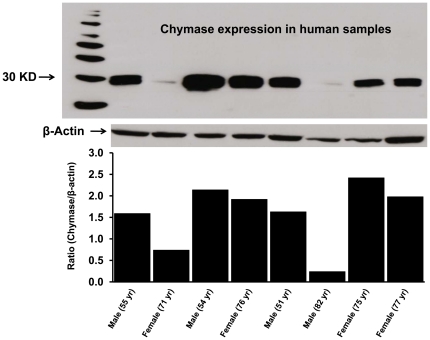
Chymase protein expression in human atrial tissue.Chymase protein expression in human atrial samples was analyzed by western blotting using a primary monoclonal anti-human chymase antibody (CMA1 antibody from R&D System, Cat# MAB-4099; 2 µg/mL). The plasma membrane (50 µg protein) were separated by gel electrophoresis and transferred on PVDF. Equal protein loading on each lane was confirmed by β-actin detection (1∶5,000 dilution). Level of protein expression was shown as relative O.D. ratio (chymase/β-actin) for each human sample.